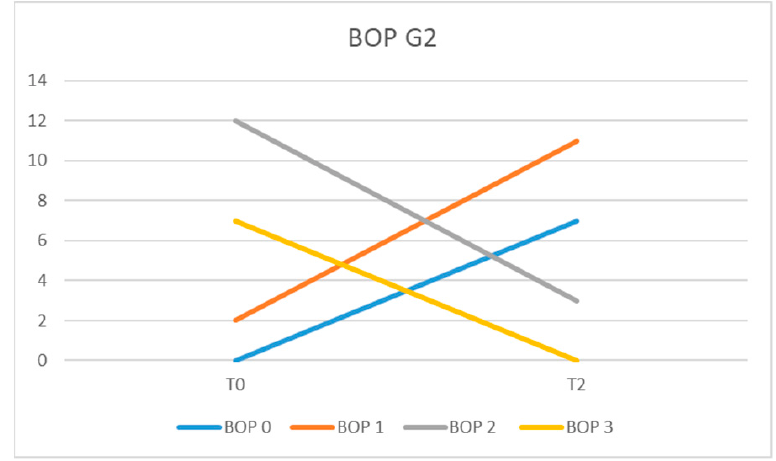
Figure 7. BOP values in group G at moments T0 and T2 .